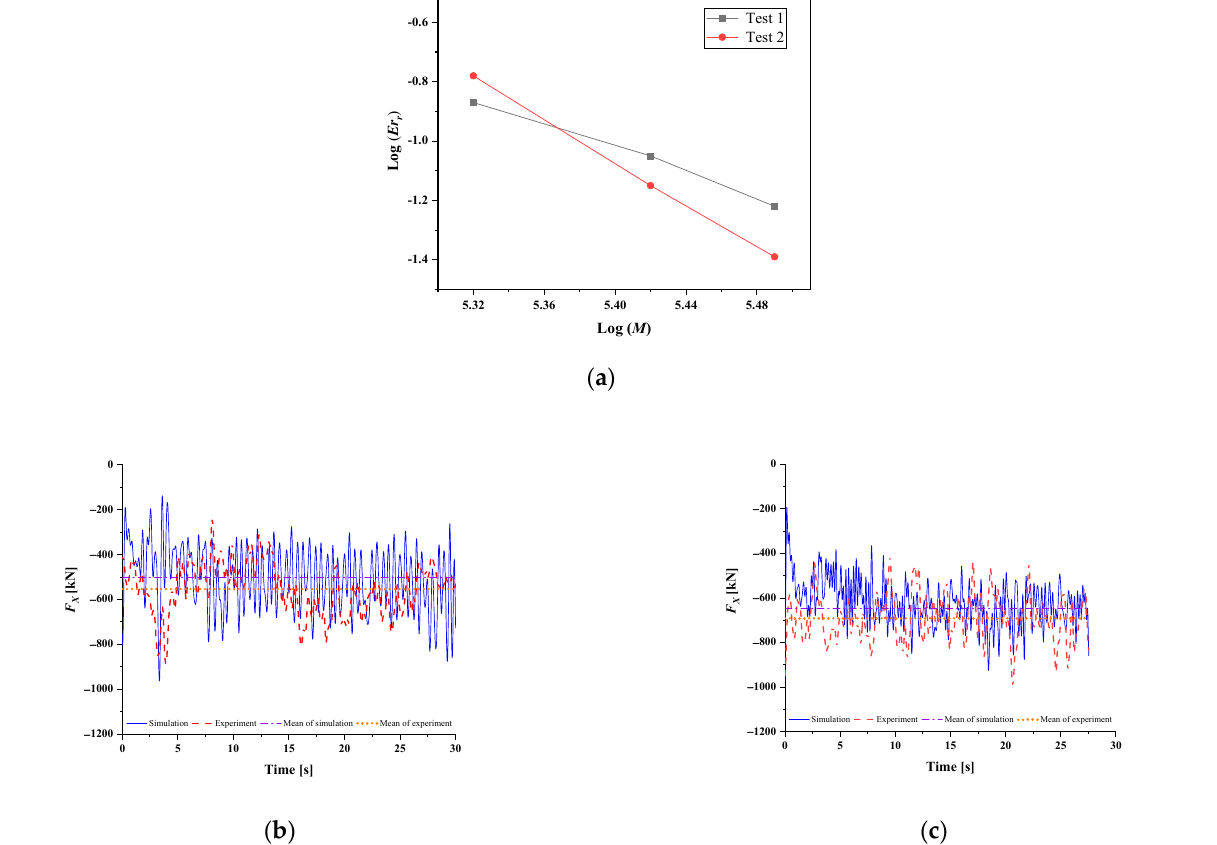
Figure 5. Convergence tests of ice resistance ( a ) and comparisons of longitudinal force between experiments and simulations, where ( b ) is the result of Test 1 and ( c ) is the result of Test 2, respectively. Table 4. Ice resistances of numerical simulations and experiments. Test No.